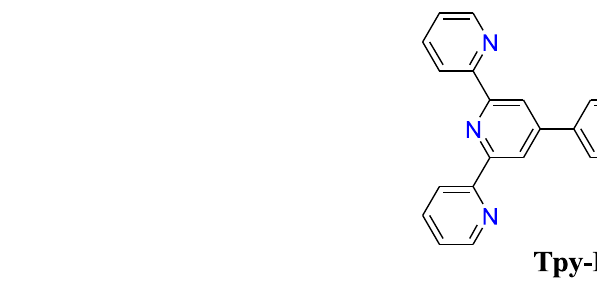
Frontiers in Chemistry |